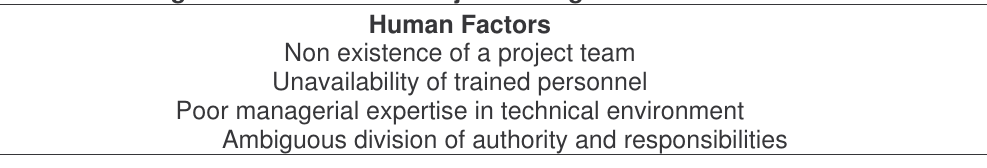
Figure 5: Problems of Project Management in Ghana